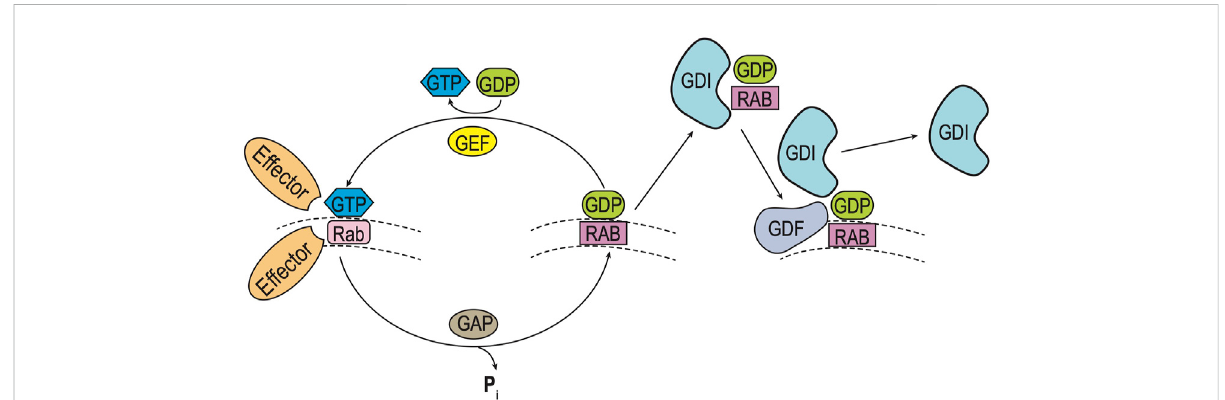
FIGURE 1 Rab GTPase Cycle. Rab (and Ypt) GTPases cycle between inactive and active forms as they move between intraorganellar membranes (e.g. ER, Golgi) (Pfeffer and Aivazian, 2004). Such membrane cycling is dependent upon the type of guanine nucleotide bound. Left: Inactive Rab-GDP is converted to its active form by exchange of GDP for GTP, catalyzed by a guanine nucleotide exchange ( GEF ) factor. Inactivation of the Rab-GTP occurs by hydrolysis of GTP, which is stimulated by a GTPase-activating protein ( GAP ). Right: Cycling of Rab-GDP between membranes requires binding of a Rab GDP dissociation inhibitor ( GDI ), to prevent Rab activation as it moves through the cytoplasm. Ultimately speci fi c membranetargetingismediatedbyamembrane-boundGDIdisplacementfactor( GDF ),whichreleasesRab-GDPfromtheGDItoallowforinsertion into its cognate